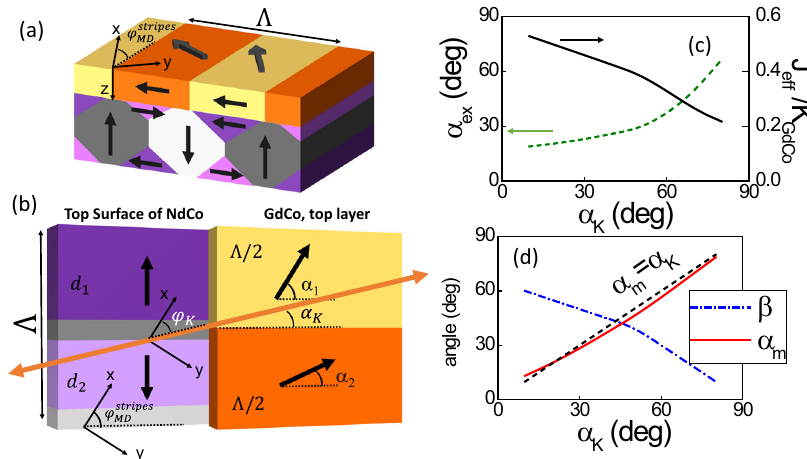
Fig. 5 Model of in-plane interactions. a Sketch of cross section of the multilayers with asymmetric closure domains. b Sketch of relevant exchange interactions between asymmetric closure domains (width d 1 and d 2 ) at the top surface of the NdCo layer and quasi domains at GdCo top layer (oriented at α α 1 and 2 ). Double arrow indicates in-plane easy axis at top GdCo layer oriented at an angle exchange energy J eff K black solid line ð Þ and exchange angle α ex green dashed line ð Þ on α K for J int = K GdCo = 1 and d 1 (cid:2) d 2 ¼ 0 : 2 Λ . d Dependence of average GdCo magnetization orientation α m (red solid line) and oscillation aperture β (blue dotted line) on α K . Dashed black line corresponds to the condition of symmetric oscillation around the easy anisotropy